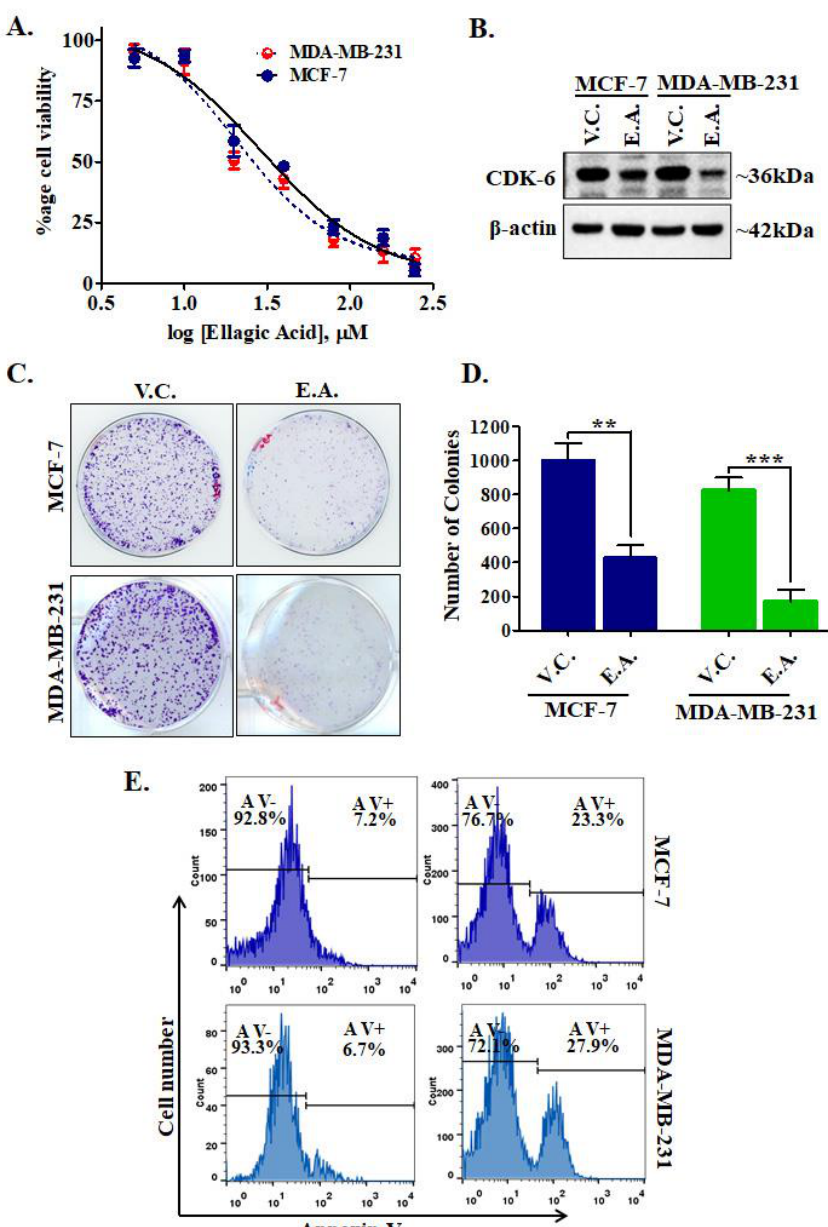
Figure 8. Treatment of EA decreases cell viability, CDK6 expression, colonization, and induces apoptosis in cancer cells. ( A ) The cell proliferation profile showing the e ff ect of EA treatment on the viabilities of MCF-7 and MDA-MB-231 cells. The selected cancer cells were incubated with an increasing dose of EA for 48 h and respective cell viabilities were estimated using MTT assay. Each data point shown is the mean ± SD from n = 3. ( B ) Protein expression of CDK6 in EA and vehicle-treated MCF-7 and MDA-MB-231 cells. ( C ) Colony formation assay performed with respective IC 50 concentrations of EA with selected cell lines. ( D ) The bar graph representation for the total number of colonies in each treatment group and compared with the vehicle controls. ( E ) Apoptosis studies showing the percentage of Annexin-V positive / negative cells stained after EA treatment for 48 h. The data were statistically analyzed using Student’s t -test for unpaired samples, ** p < 0.01, *** p < 0.001 compared to the vehicle control group.